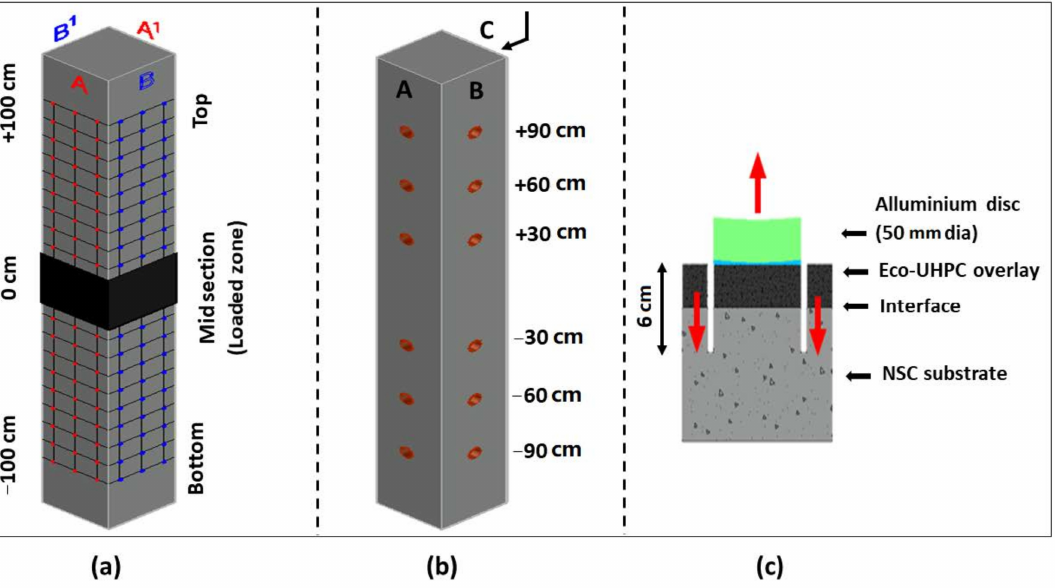
Figure 4. ( a ) Ultrasonic Pulse Velocity (UPV) measuring nodes—Red (A-A’), Blue (B-B’); ( b ) spots for pull-o ff test (marked in red); ( c ) schematic representation of pull-o ff